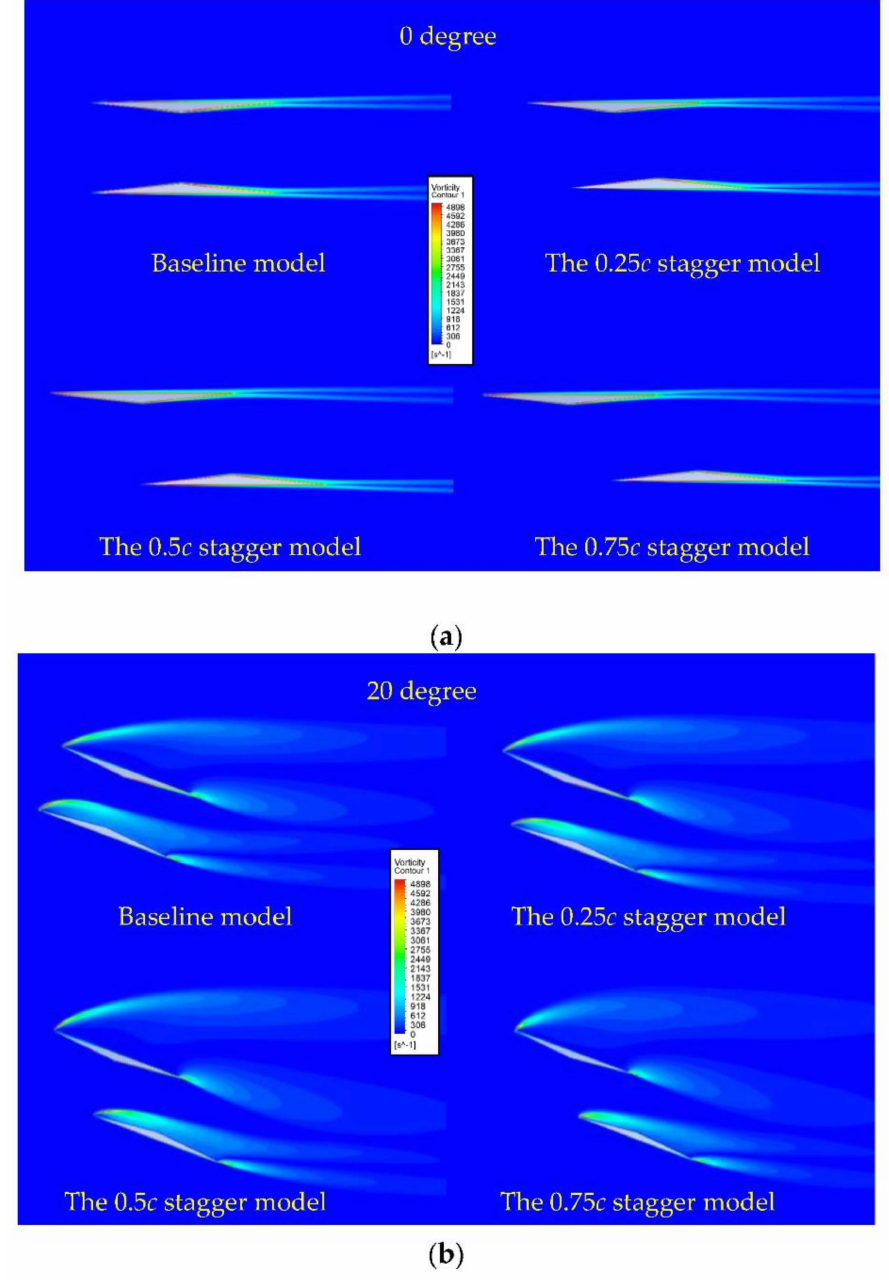
Figure A5. Vorticity distributions around the staggered biplane configuration (CFD results): ( a ) 0 de- grees; ( b ) 20